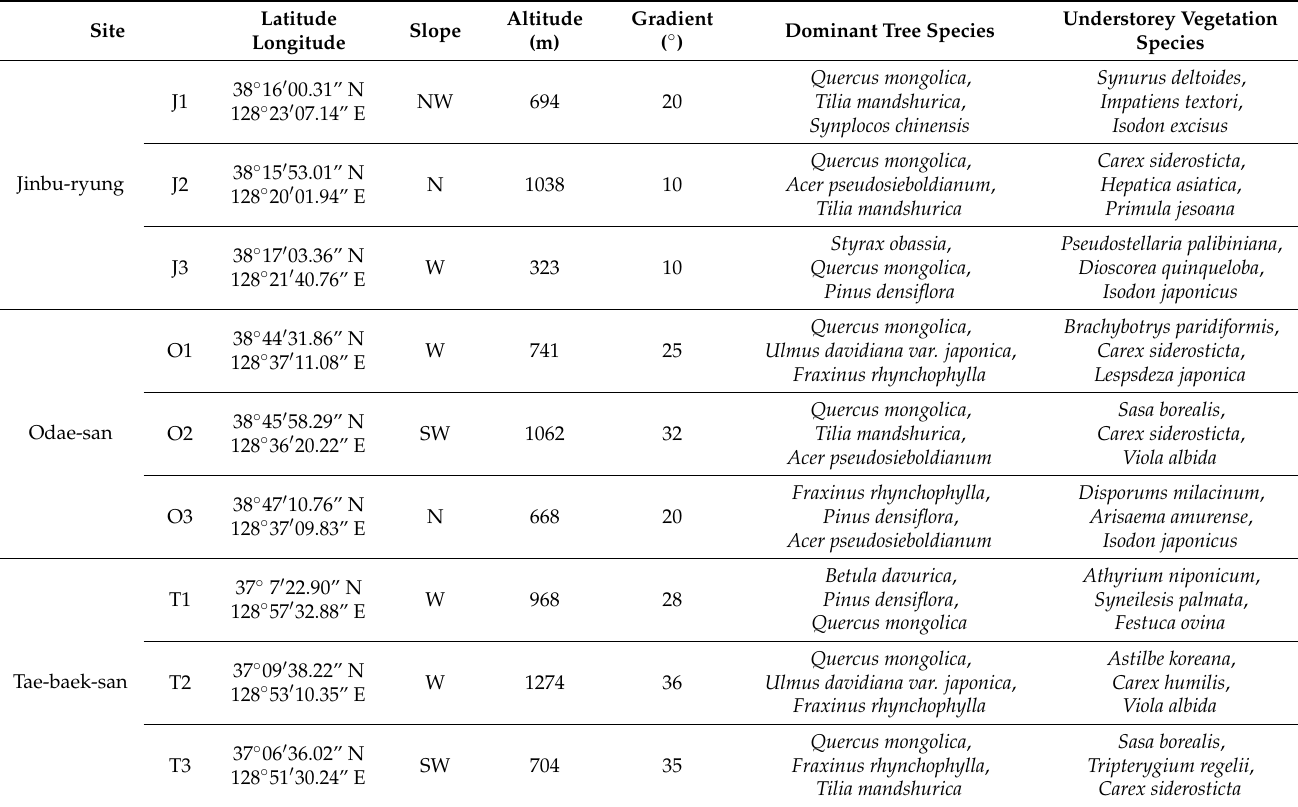
Table A1. Habitat and environmental information on the study sites on the Baekdudaegan Mountain Range, Korea.